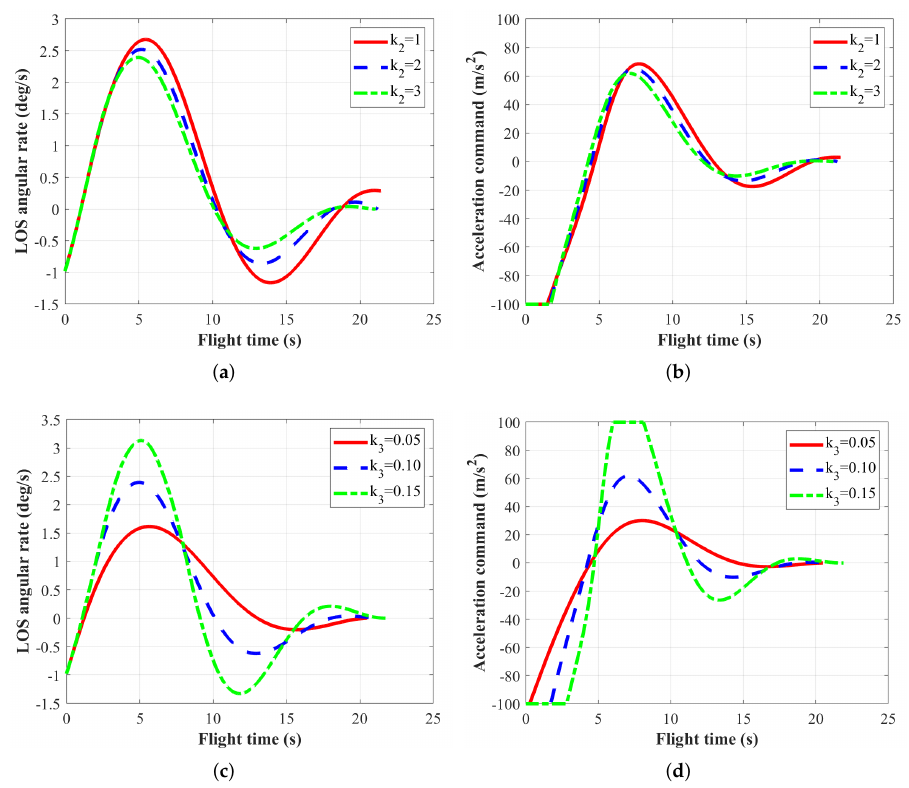
Figure 5. Comparative simulation results under different parameters: ( a ) LOS angular rate with different k 2 ; ( b ) acceleration command with different k 2 ; ( c ) LOS angular rate with different k 3 ; ( d ) acceleration command with different k 3